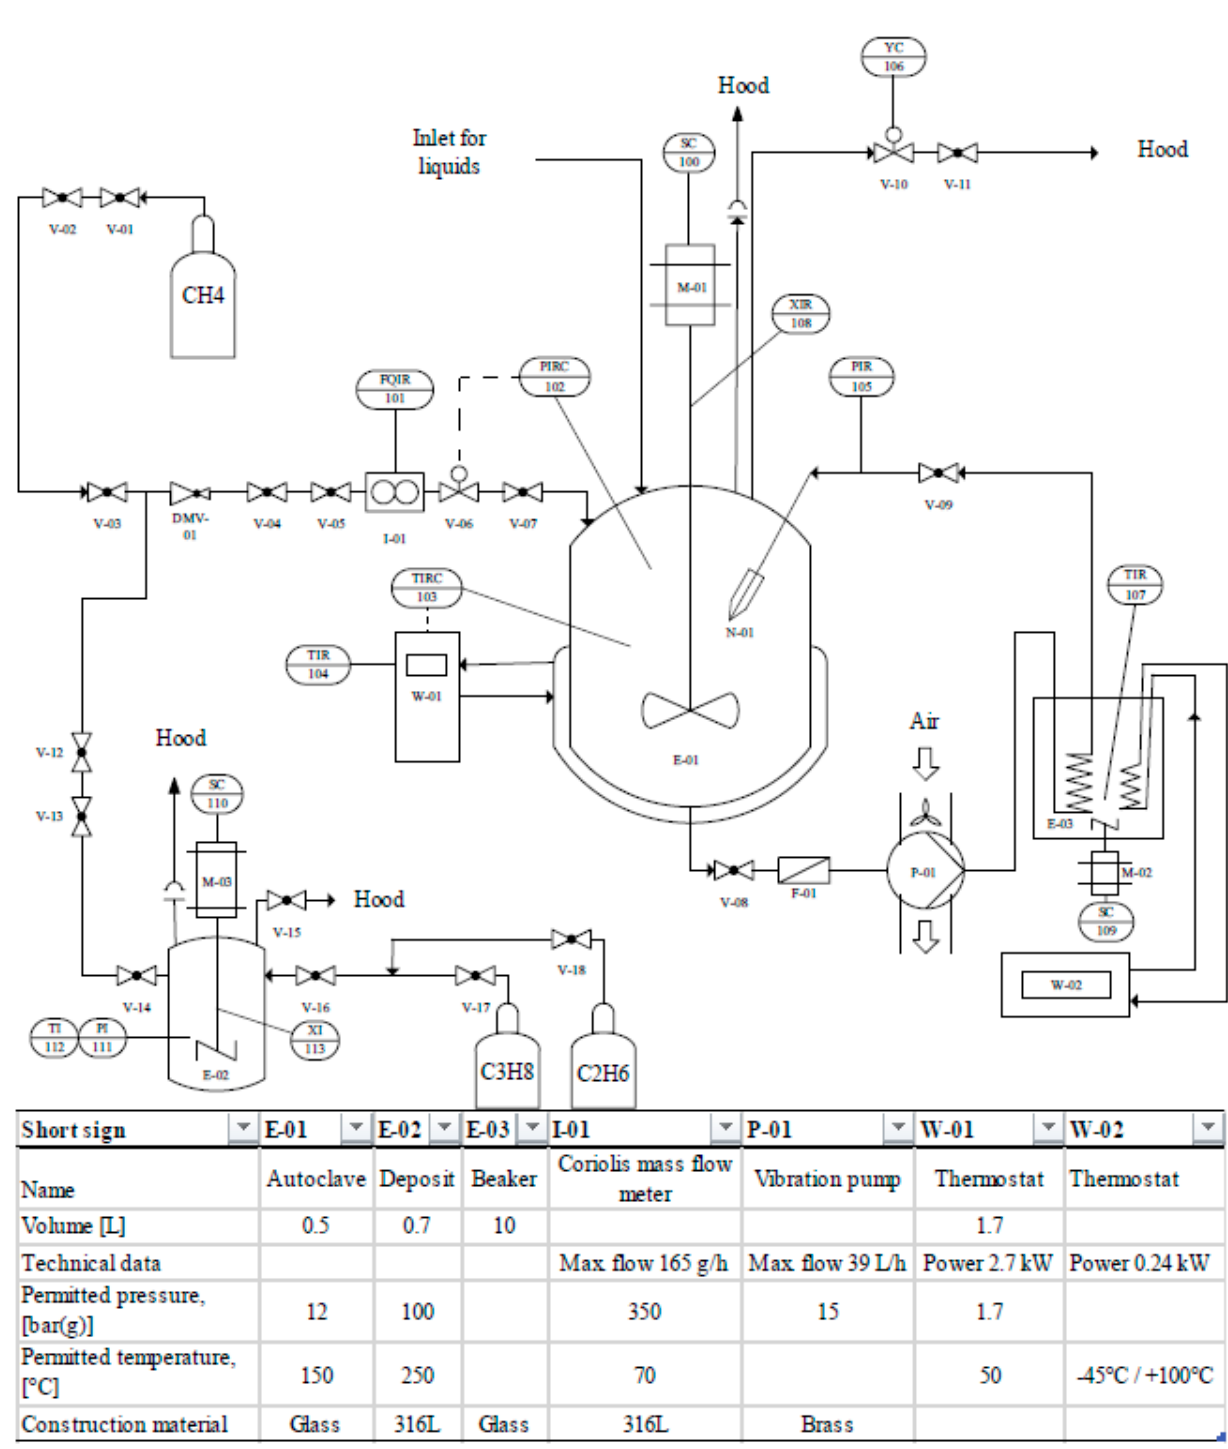
Figure 5. Simplified P&ID of the experimental setup.